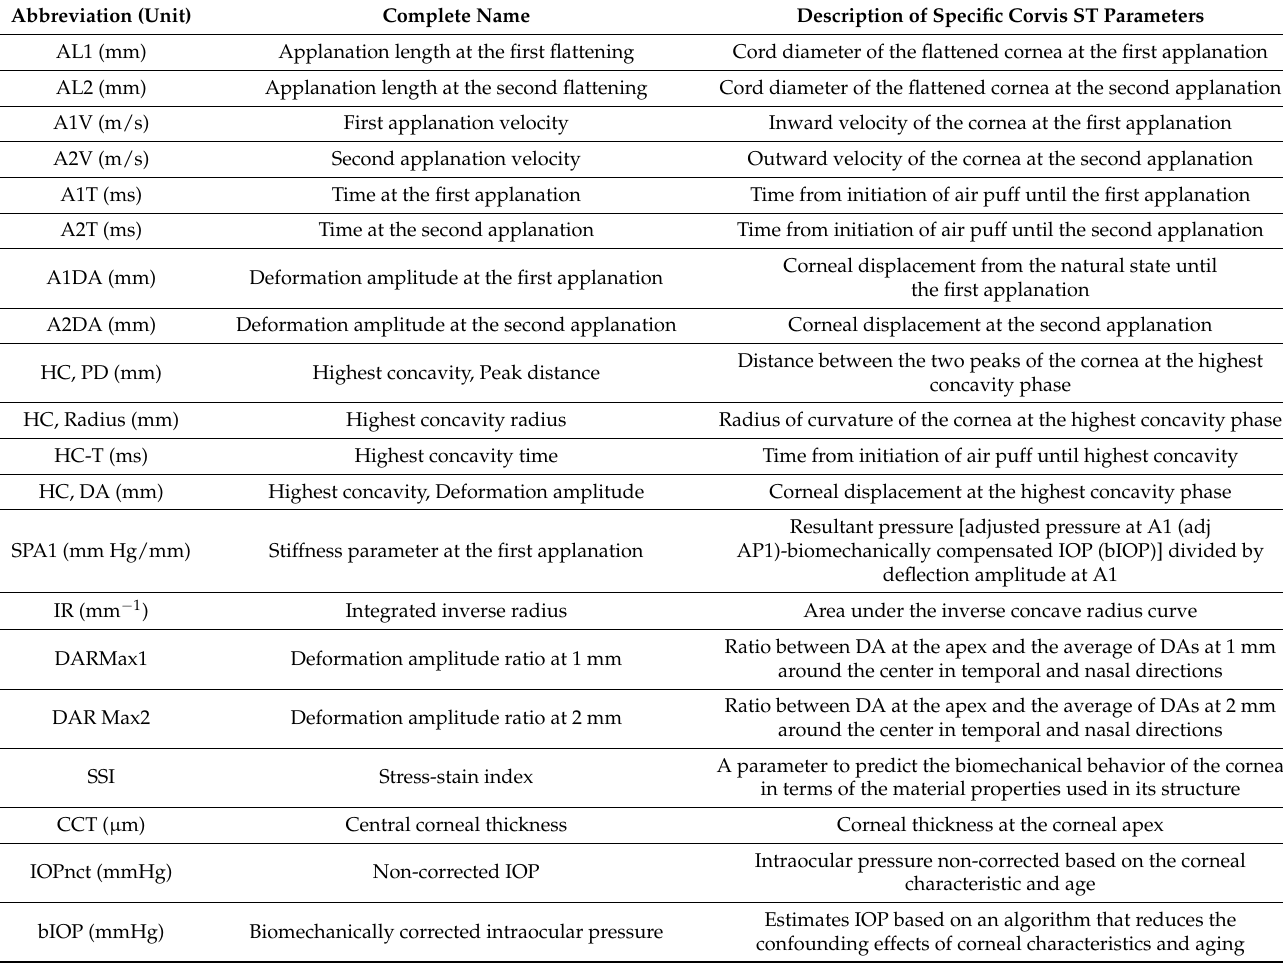
Table 1. Parameters measured by Corvis ST included in this